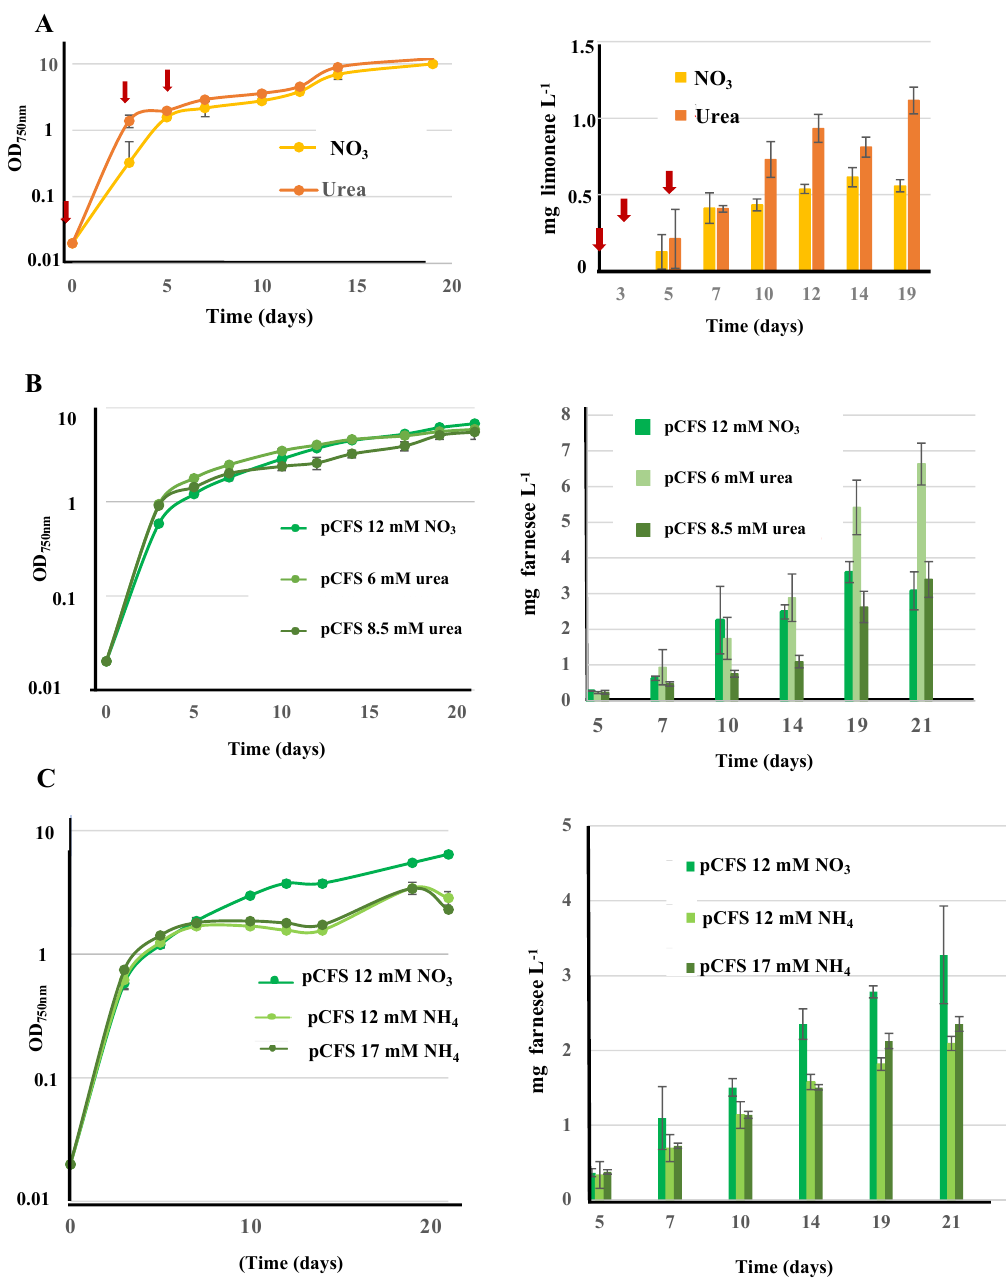
Figure 7. Influence of various nitrogen sources on the growth and terpene production of the Synechococcus PCC 7002 strains harboring pCLS ( A ) or pCFS ( B , C ). Cells growing exponentially under standard conditions (12 mM nitrate) were washed twice and resuspended in a nitrogen-free medium. ( A ) At the times indicated by red arrows (days 0, 3, and 5), the same amount of nitrogen was supplied as either 4 mM NaNO 3 or 2 mM urea. ( B , C ) The indicated doses of either nitrate or urea ( B ), ammonium (NH 4 Cl), or nitrate ( C ) were supplied at the onset of the cultures. In all of these assays, the dodecane overlay (20% vol/vol) was added on day 3. Error bars represent standard deviations from biological triplicates.